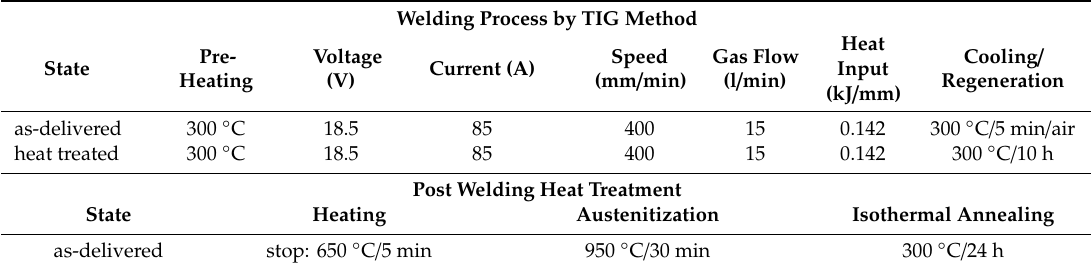
Table 3. Parameters of the welding process, regeneration technique, and post welding heat